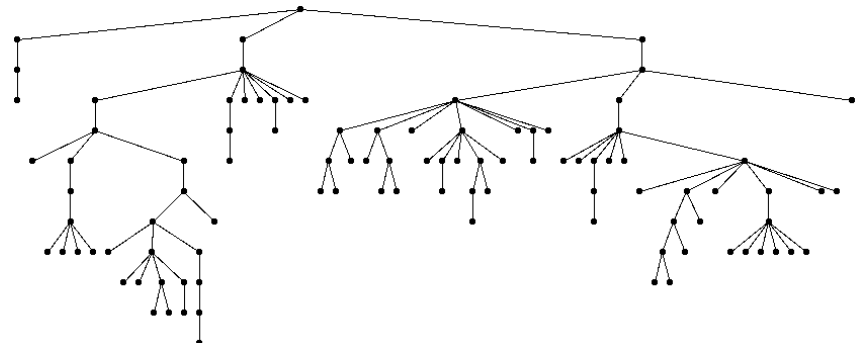
Fig. 10: An object grammar for planar trees.